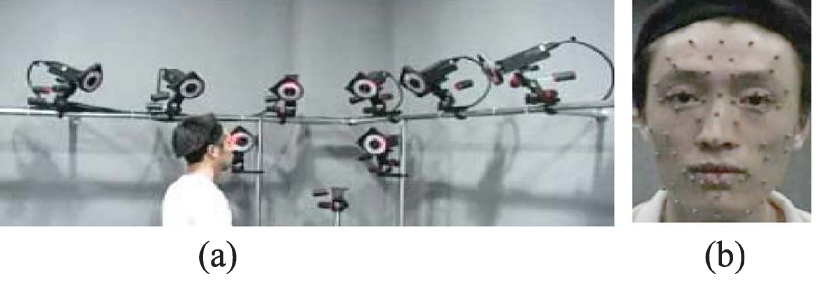
Fig. 5. Facial Mo-Cap environment (a) and facial marker setup